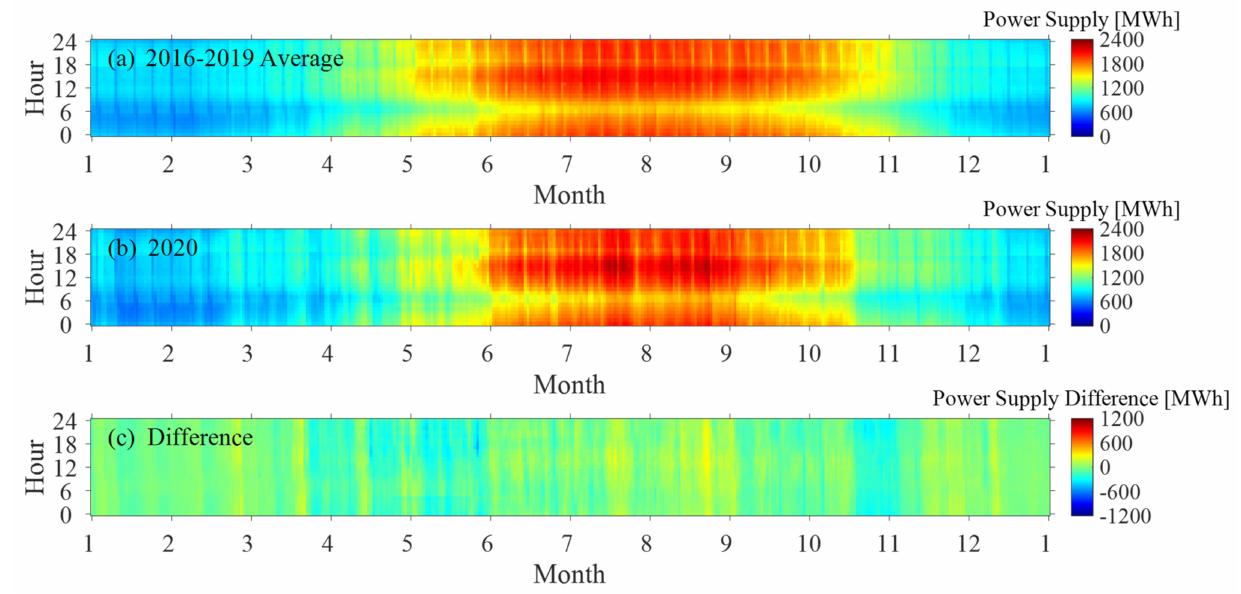
Figure 2. Electric power supply to Sharjah City using ( a ) average hourly demand between 2016 and 2019, ( b ) hourly demand in 2020, and ( c ) the hourly difference between 2020 and the average of previously reported